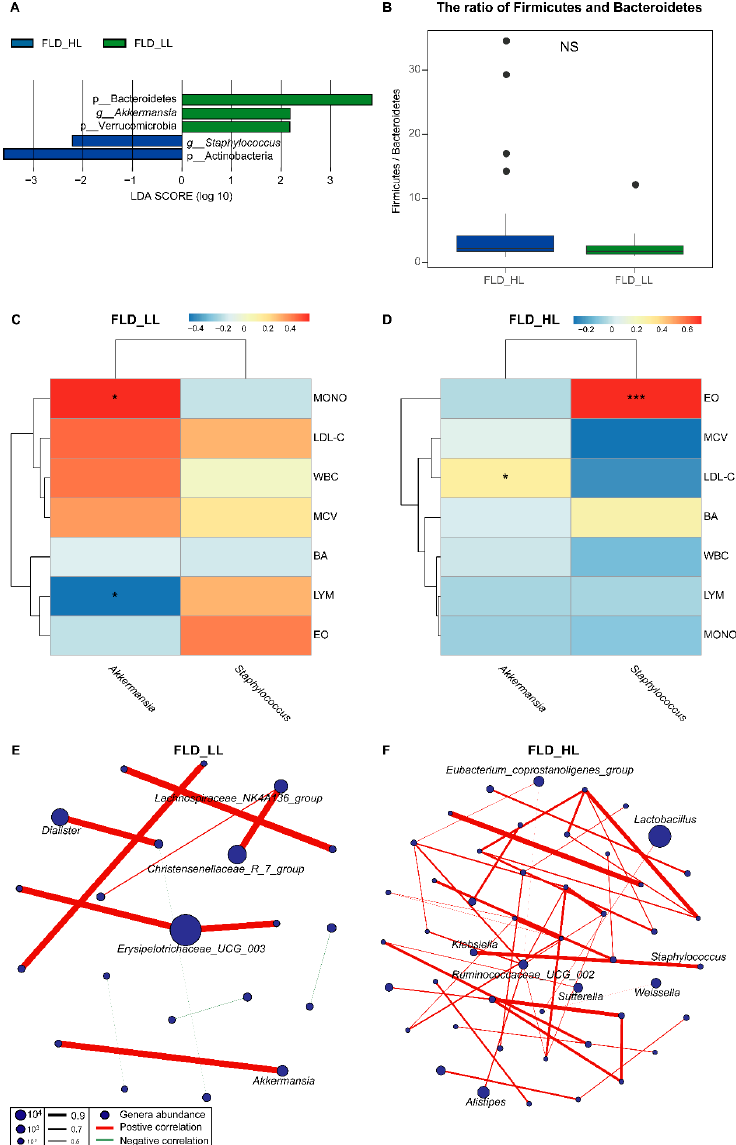
Figure 3. ( A ) Bacteroidetes, Verrucomicrobia, and Akkermansia were enriched in the FLD_LL group, while Actinobacteria and Staphylococcus were enriched in the FLD_HL group. ( B ) There was no